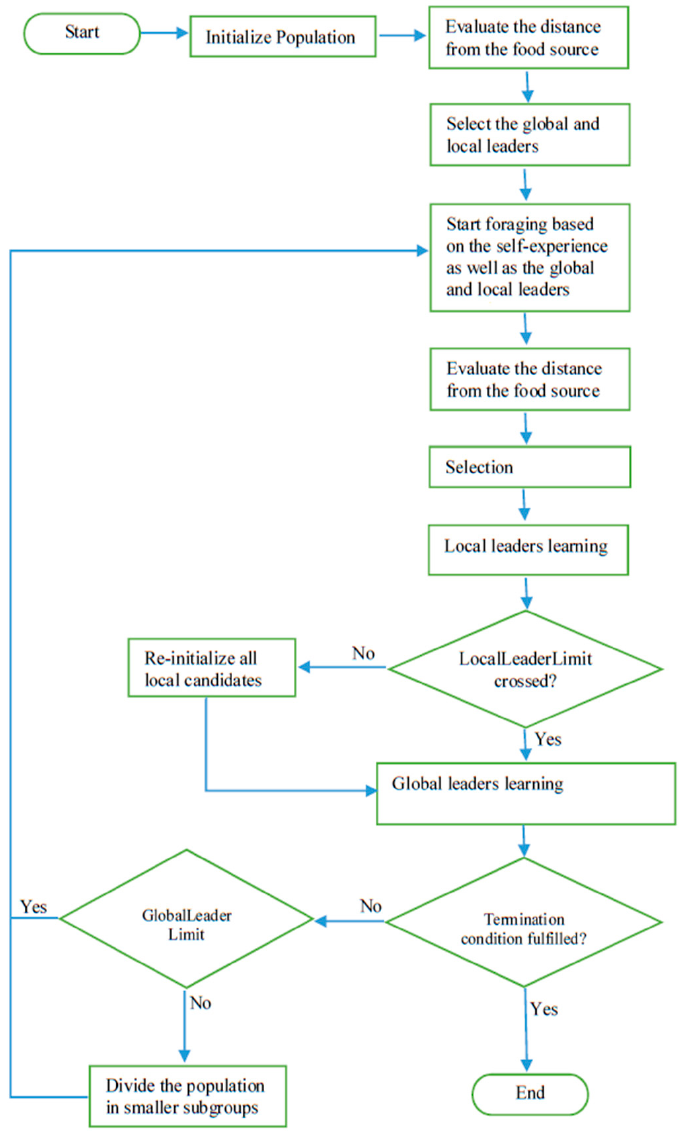
Figure 4. SMO algorithm work flow diagram.